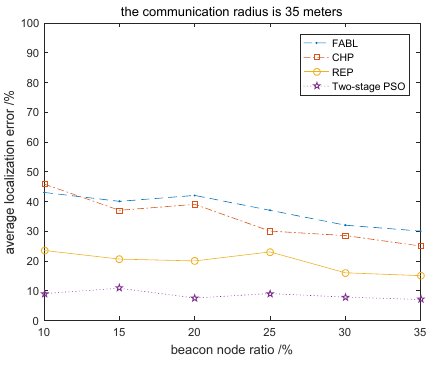
Figure 7. Relationship between beacon node ratio and localization results.